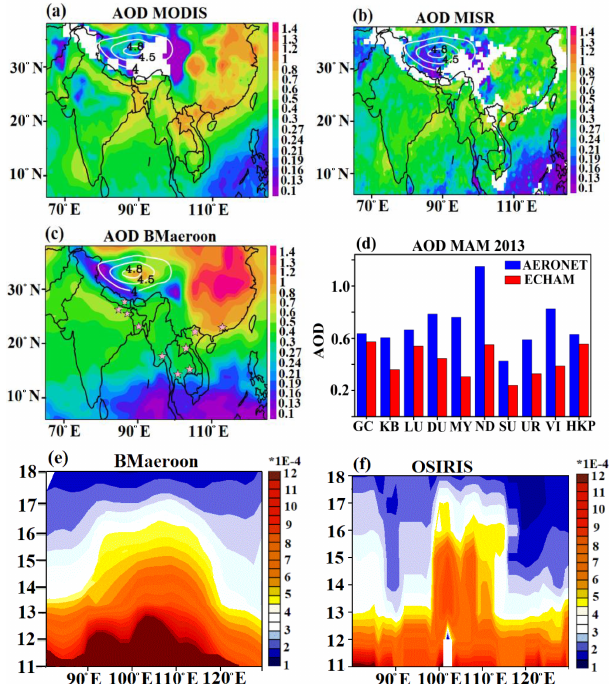
Figure 2. (a) Aerosol optical depth (AOD) averaged for spring 2013 from MODIS, (b) same as (a) but from MISR, and (c) same as (a) but from ECHAM6–HAMMOZ BMaeroon sim- ulation. White contours in (a) – (c) indicate the orography (km) of the Tibetan Plateau. (d) Comparison of simulated AOD (from BMaeroon) averaged for spring 2013 with AERONET ob- servations at Gandhi College (GC; 25.81 ◦ N–85.12 ◦ E), Kath- mandu Bode (BD; 27.68 ◦ N–85.39 ◦ E), Lumbini (LU; 27.49 ◦ N– 83.28 ◦ E), Dhaka University (DU; 23.72 ◦ N–90.39 ◦ E), Myanmar